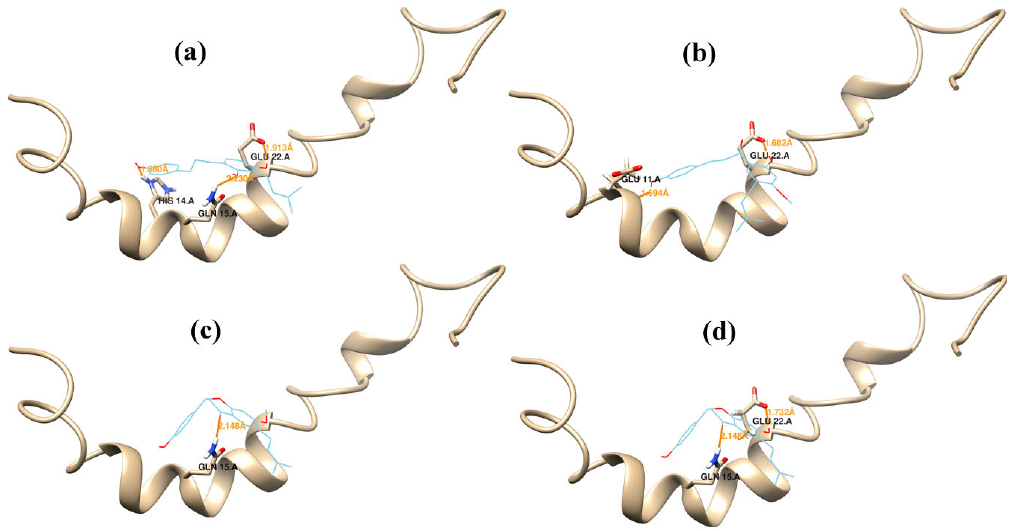
Figure 4. Docking results. Binding conformations of compounds 1 ( a ), 2 ( b ), 3 ( c ), and 4 ( d ) at the binding site of A β 42. Hydrogen bonds are represented as yellow lines. Table 1. Amino acid residues of A β 42 that interact with compounds 1 – 4 and their Δ G values ob ‐ tained via docking studies .